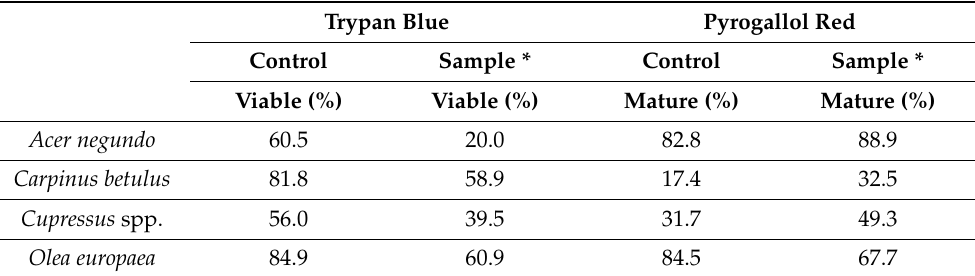
Table 4. Percentage of viability (Trypan blue) and maturity (Pyrogallol red) of the 4 pollen types considered in this